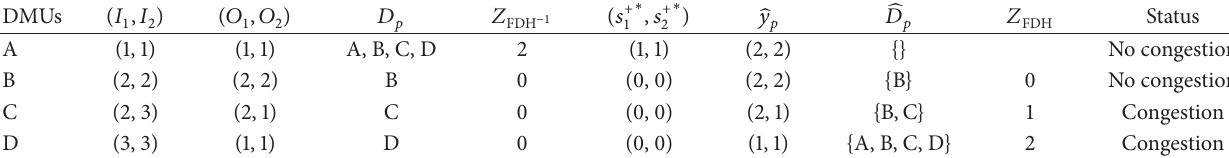
Table 3: Data set and results of Part (a) of the proposed algorithm in Example 2.